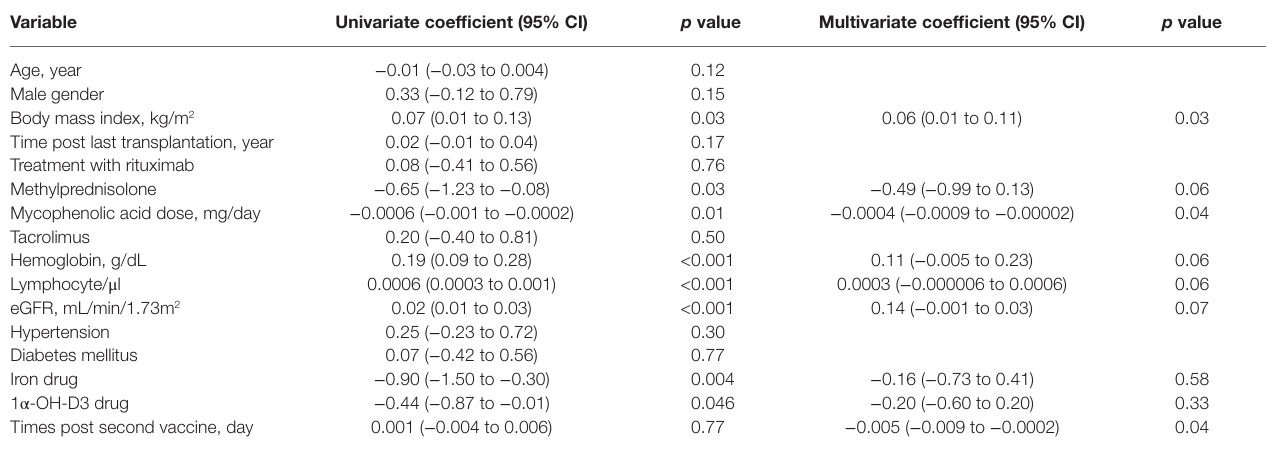
TABLE 3 | Factors associated with anti-S SARS-CoV-2 antibody levels by univariate and multivariate liner regression models.